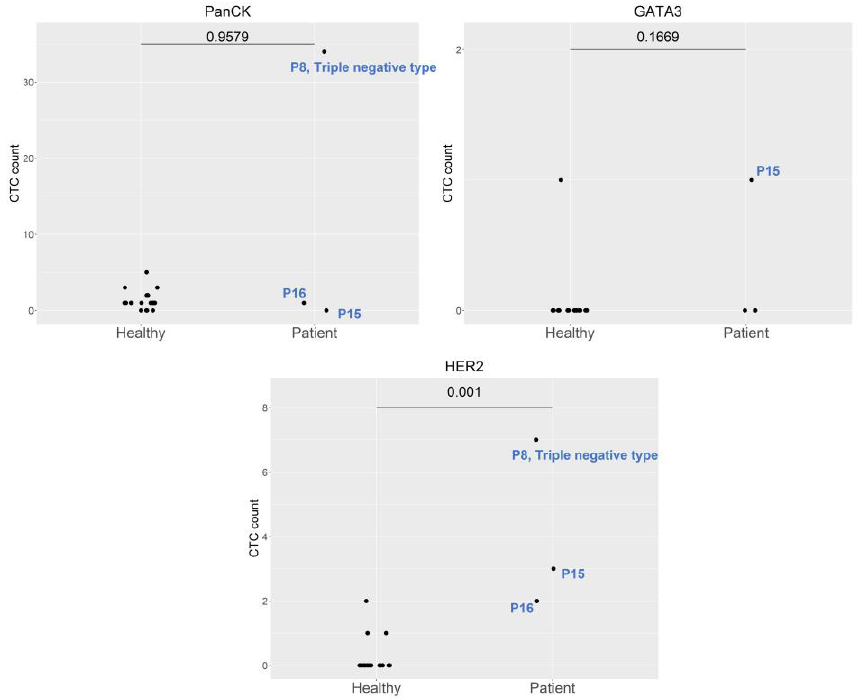
Figure 5. Comparison of the expression of different molecular markers between healthy controls and breast cancer patients. Abbreviations: P8, Patient 8; P15, Patient 15; and P16, Patient 16.